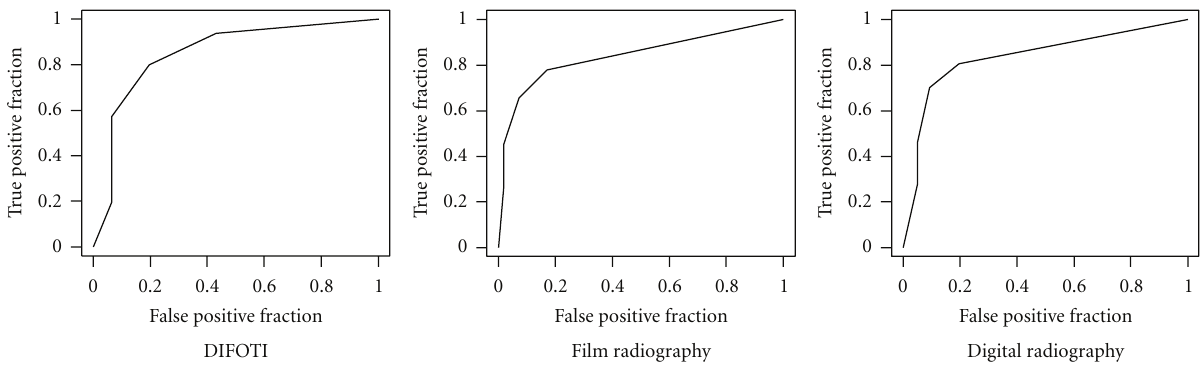
Figure 3: ROC curves for the three methods based on results from 8 observers at the diagnostic threshold D3 (dentin caries).